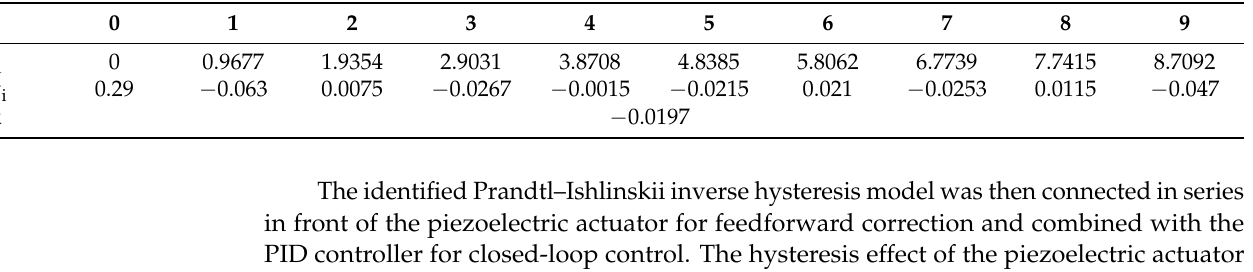
Figure 7. Identification results of the Prandtl–Ishlinskii inverse hysteresis model. Table 1. Identified parameters of the Prandtl–Ishlinskii inverse hysteresis model.